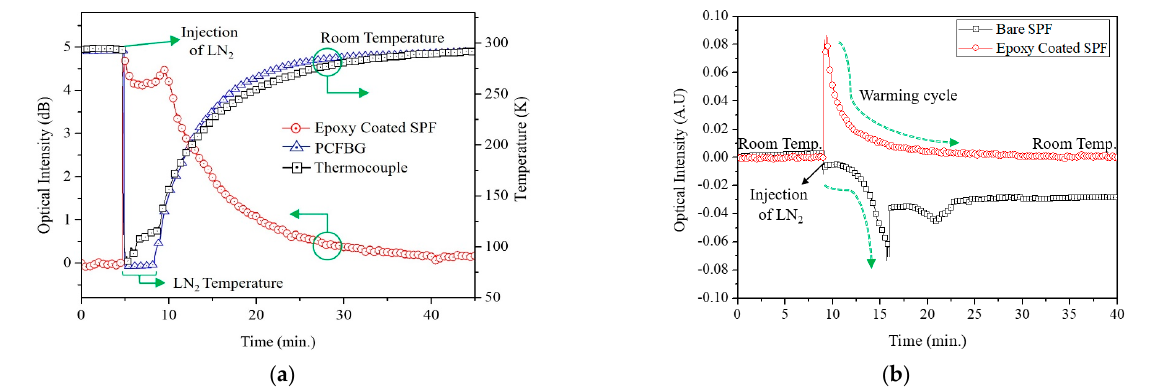
Figure 4. Performance comparison of the proposed sensor: ( a ) Bare SPF sensor vs. epoxy-coated SPF sensor; ( b ) reference sensors (PCFBG and T-type thermocouple) vs. epoxy-coated SPF sensor.